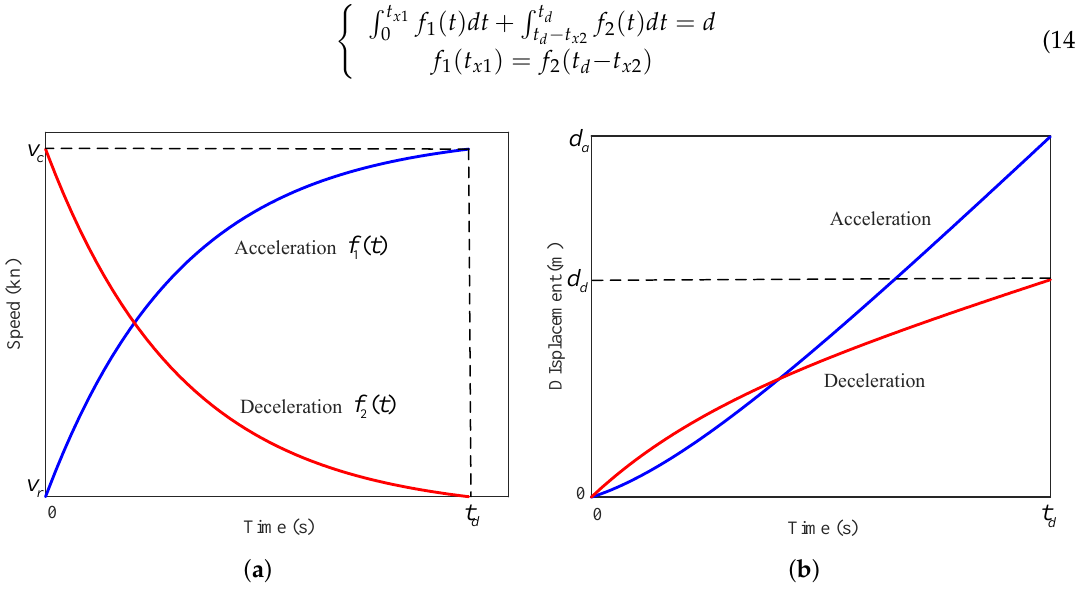
Figure 8. Acceleration and deceleration test: ( a ) Speed curves. ( b ) Displacement